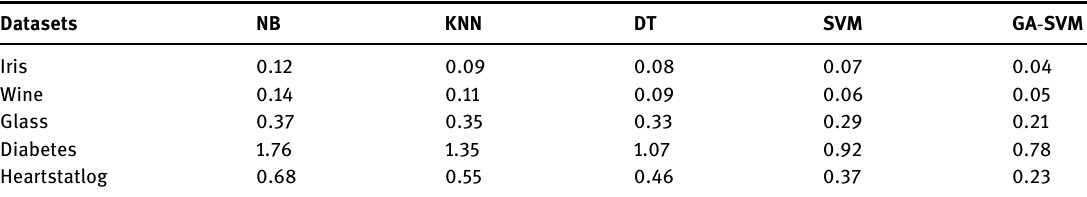
Table 5: Comparison of the testing time between di ff erent machine learning algorithms ( unit: s )